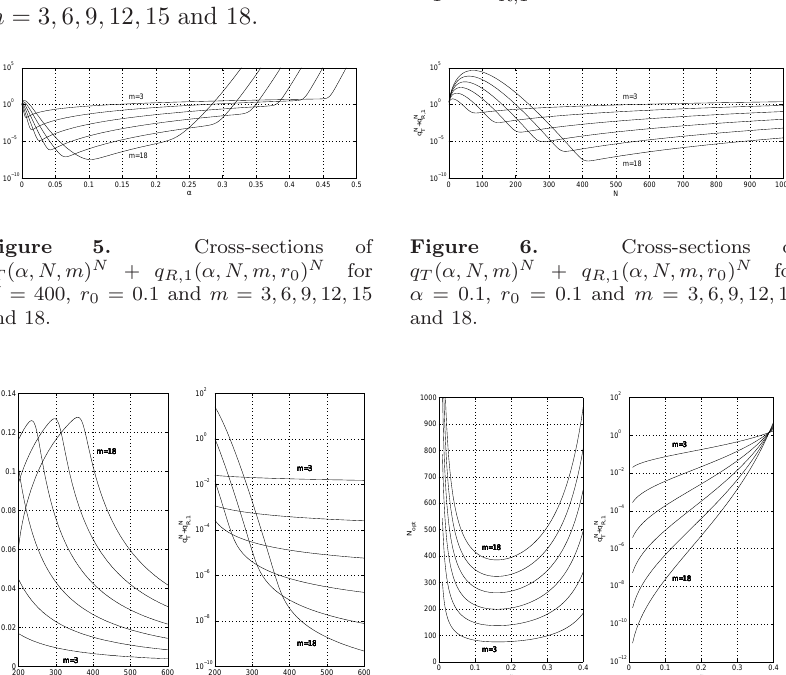
Figure 7. α opt versus N (left graph) and q N versus N (right graph) for r 0 = + q N R, 1 T 0 . 1 and m = 3 , 6 , 9 , 12 , 15 and 18 .